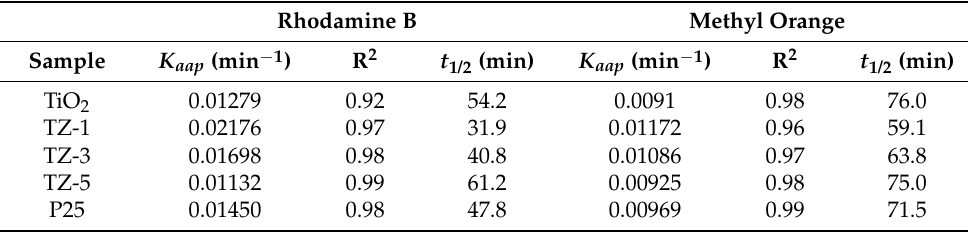
Figure 12. Kinetics profile of ( a ) RhB and ( b ) MO by TiO 2 , TZ-1, TZ-3 and TZ-5. Table 2. Kinetic parameters of the different reactions presented by TiO 2 and TZ